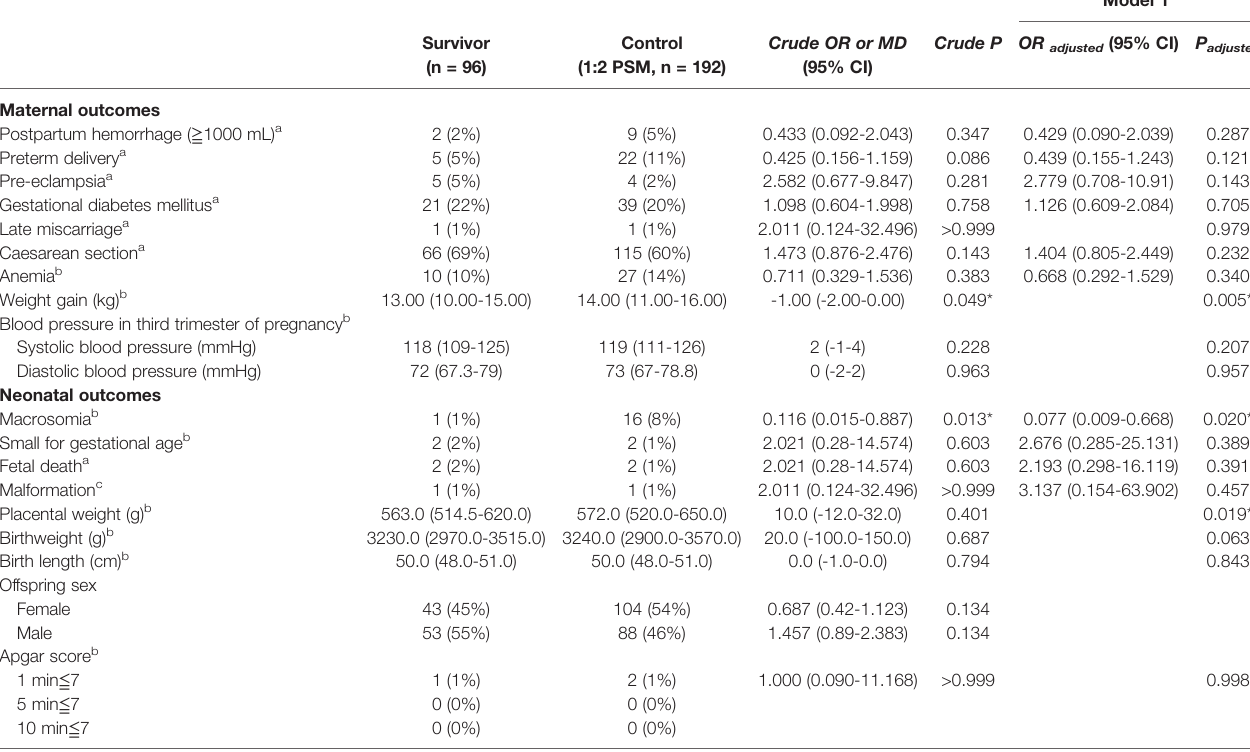
TABLE 3 | Summary of the outcomes comparing thyroid cancer survivors and control.